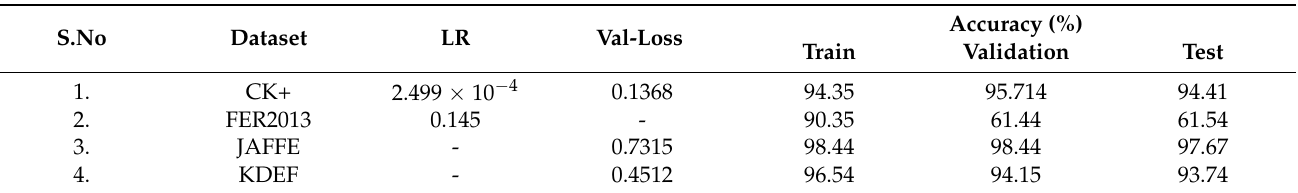
Table 6. Base model EfficientNet experimental results on CK+, FER2013, JAFFE and KDEF dataset (LR: learning Rate, Val-Loss: Validation